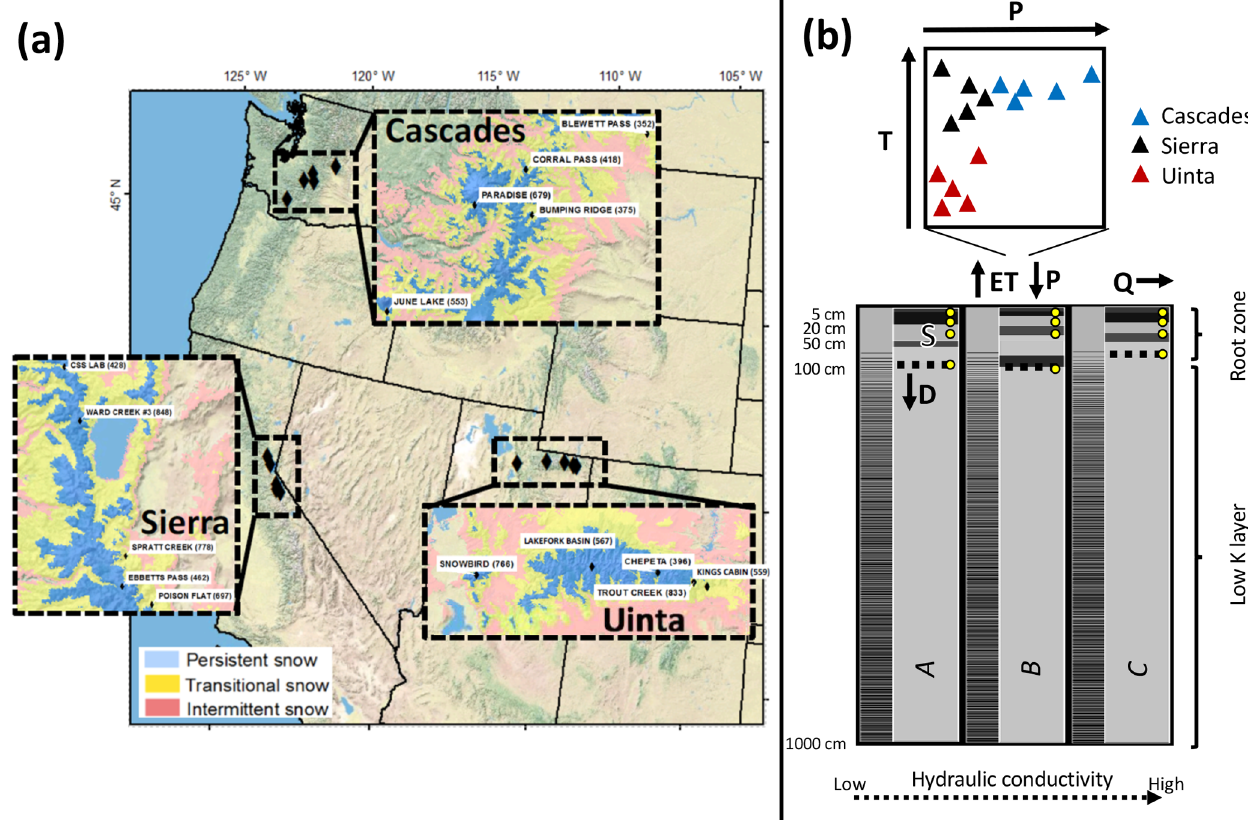
Figure 2. (a) SNOTEL sites utilized for climate scenarios in this study with insets displaying snow zones classified by mean annual snow persistence (Moore et al., 2015). (b) Modeling domain layout with yellow points showing 5, 20, and 50cm depths where volumetric water content time series were used for model calibration. The deepest yellow point is the depth where time series were extracted to calculate deep saturation. Symbols in the graph above the discretized soil profile represent the range of climate scenarios used plotted by mean annual precipitation ( P ) and mean annual temperature ( T ), and the three soil profiles below represent the soil parameter sets labeled with italicized capital letters: ( a ) loam, ( b ) sandy clay loam, and ( c ) sandy loam. Different layers in each soil profile are represented as shades of gray; shading does not indicate any property of the soil